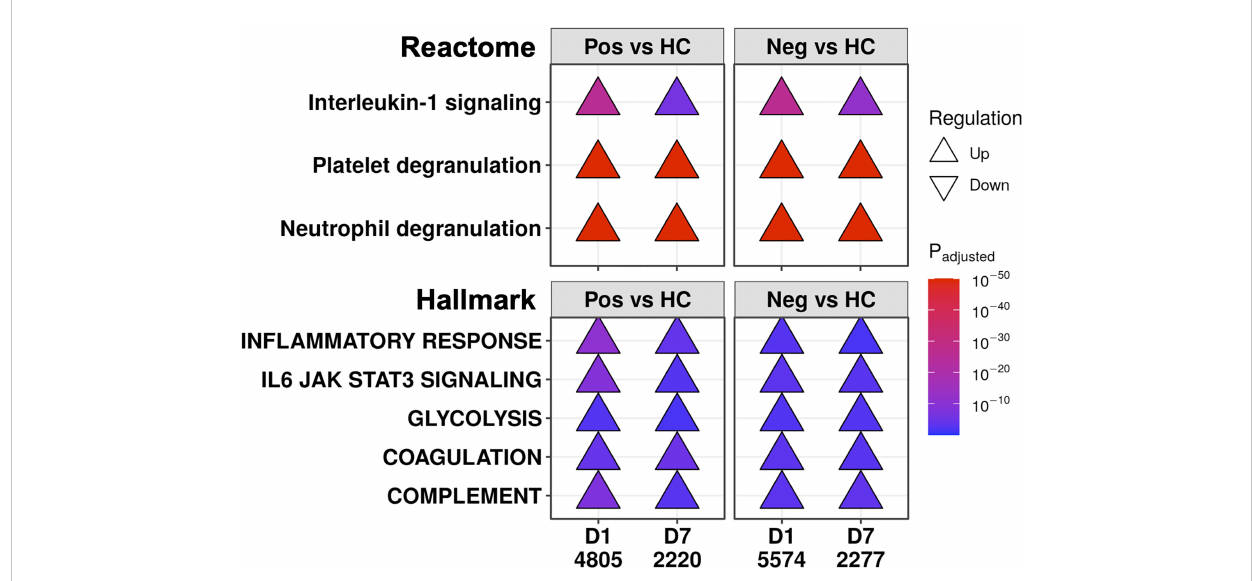
FIGURE 4 COVID-19 and non-COVID-19 sepsis patients shared immune and immune-related pathways at both D1 and D7. Subset of the enriched Reactome pathways (top) and Hallmark gene sets (bottom) using DE genes at D1 and D7 between COVID-19 (Pos) patients and healthy controls (HC), and between non-COVID-19 sepsis (Neg) patients and healthy controls. The full list of enriched pathways and gene sets are shown in Figures S3, S4. “ Upregulated ” pathways/gene sets ( D ) had genes that were overrepresented in upregulated DE genes when compared to their prevalence in the genome, suggesting an increase in their function or activity. The total numbers of DE genes in each comparison are shown under each